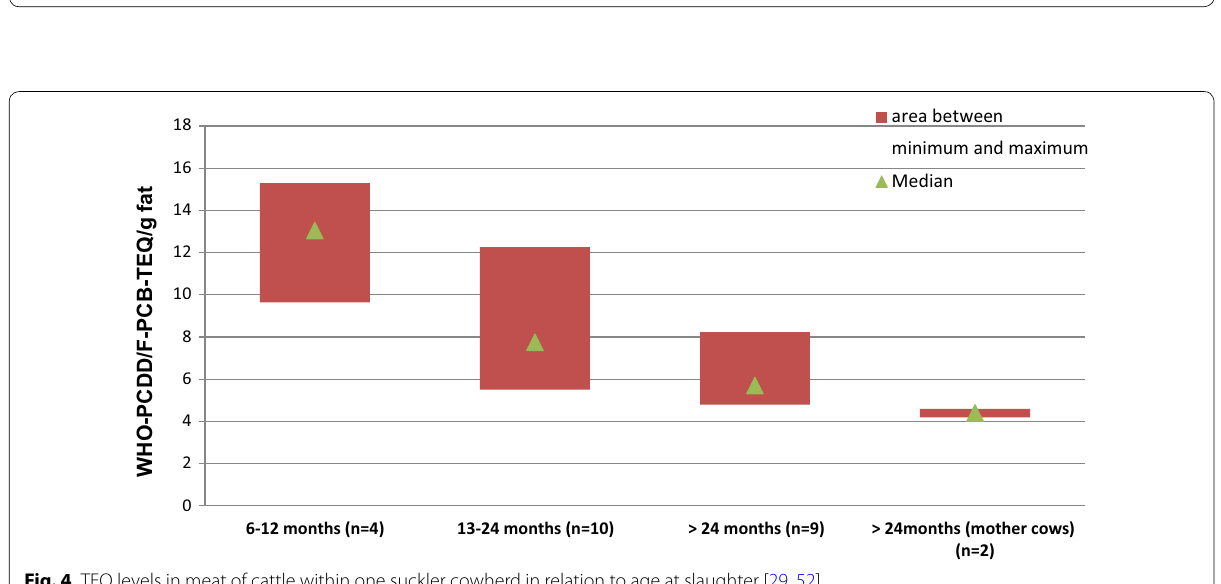
Fig. 4 TEQ levels in meat of cattle within one suckler cowherd in relation to age at slaughter [29,